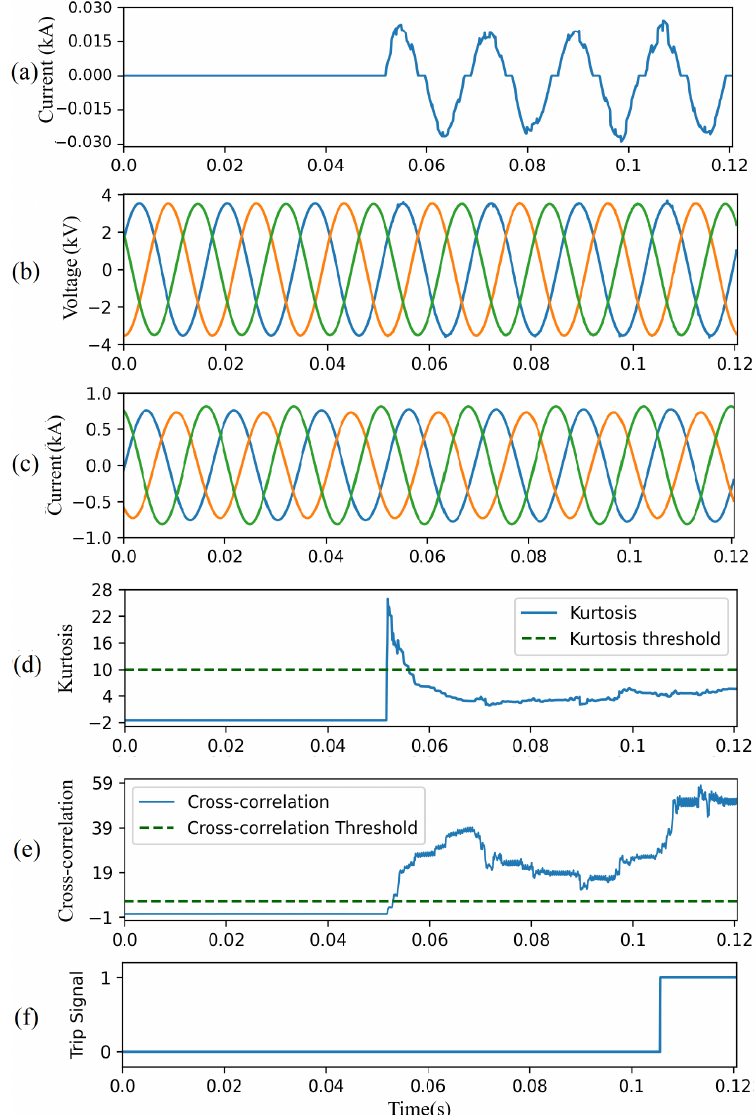
Figure 11. CAE-HIFD performance under normal and close-in HIF conditions: ( a ) HIF current, ( b ) three-phase input voltages, ( c ) three-phase input currents, ( d ) kurtosis, ( e ) cross-correlation, and ( f ) trip